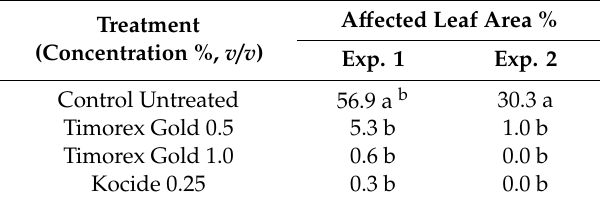
Table 1. Efficacy of formulated tea tree oil (TTO) applied prophylactically on downy mildew development induced by B. lactucae on young lettuce plants a .